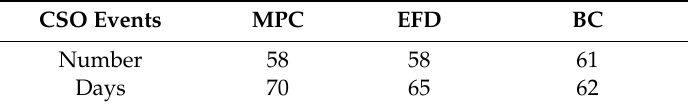
Table 7. Simulated CSO events for the MPC, EFD, and BC scenarios.